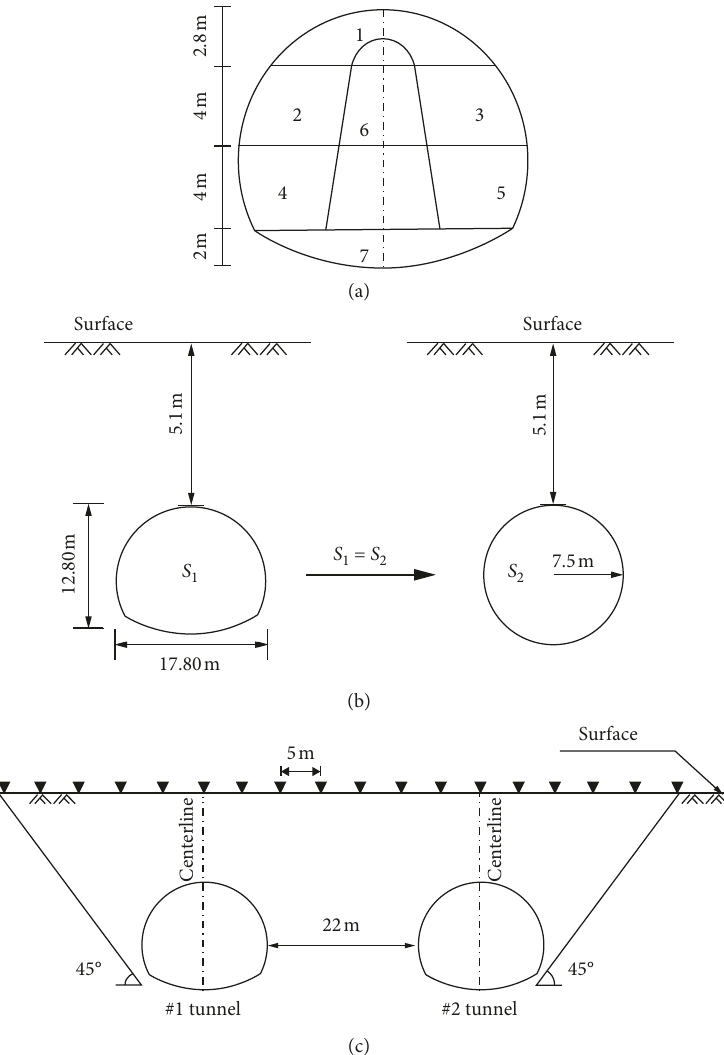
Figure 3: (a) Tunnel excavation steps. (b) Tunnel depth and section size. (c) Arrangement of surface settlement observing